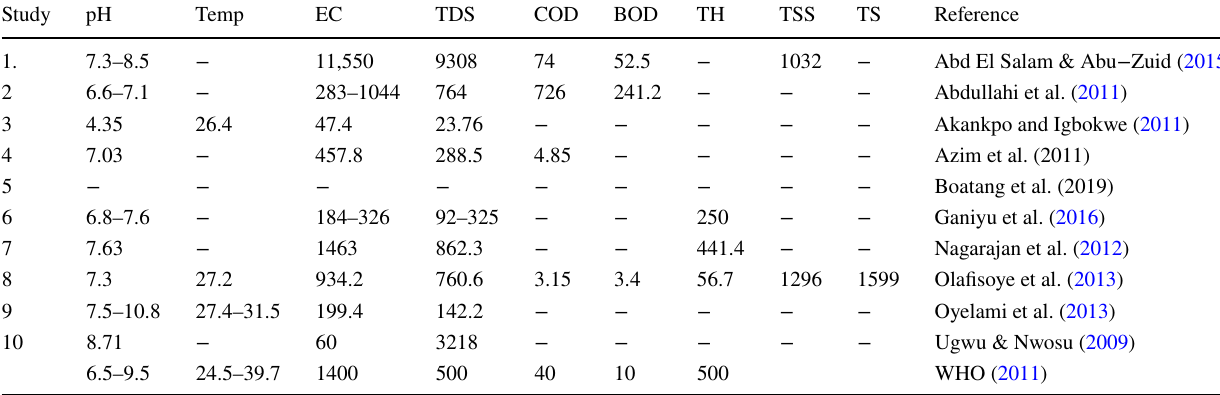
Table 7 Physical and organic properties of groundwater at various dumpsites referred